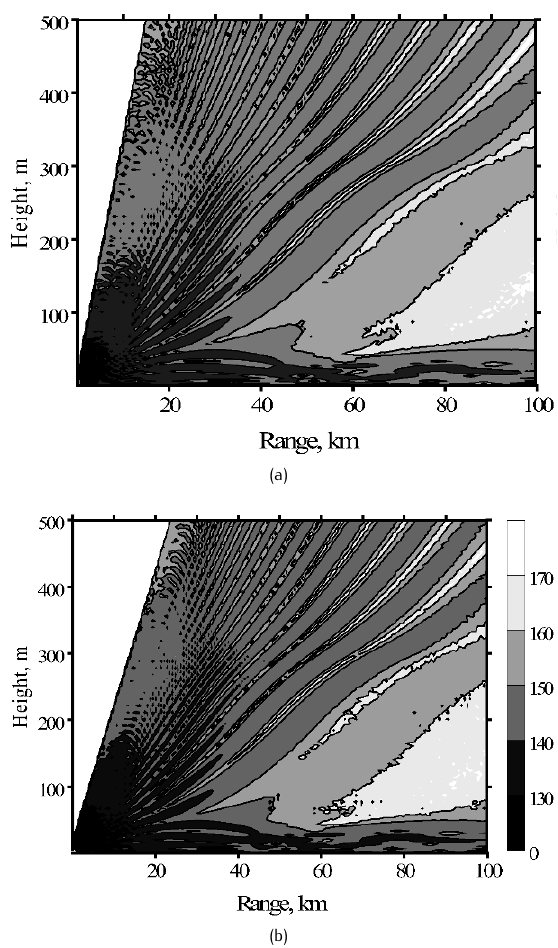
Figure 2. Path loss in dB for a cascade of two M inversions over a smooth sea surface with LTBC (a) and NTBC (b) applied at z b = 500